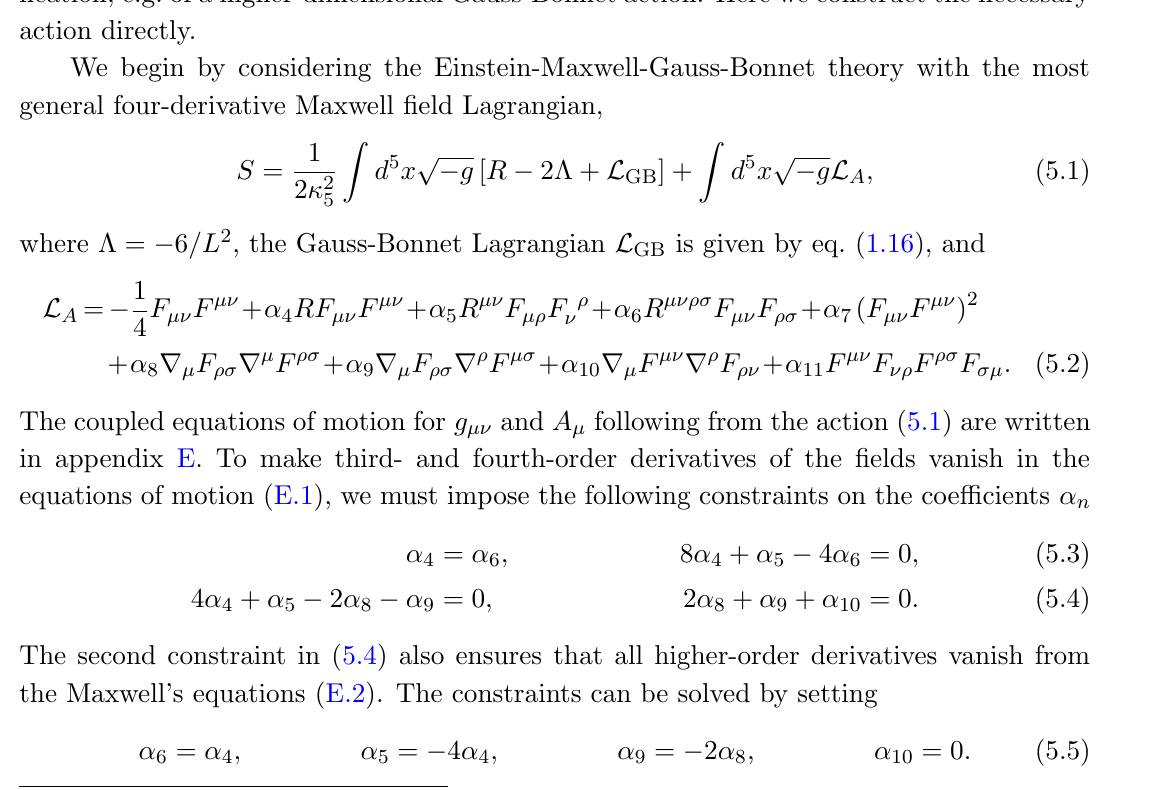
Figure 3 . Derivatives of the second-order coe(cid:14)cients (cid:21) n = f (cid:17)(cid:28) (cid:5) ; (cid:21) 1 ; (cid:21) 2 ; (cid:21) 3 ; (cid:20) g with respect to (cid:21) in units of 4 (cid:25) 2 T 2 =(cid:20) 2 , as functions of (cid:21) . 5 GB action in [133]. 34 The higher-derivative Maxwell terms may appear as a result of compacti- (cid:12)cation, e.g. of a higher-dimensional Gauss-Bonnet action. Here we construct the necessary action